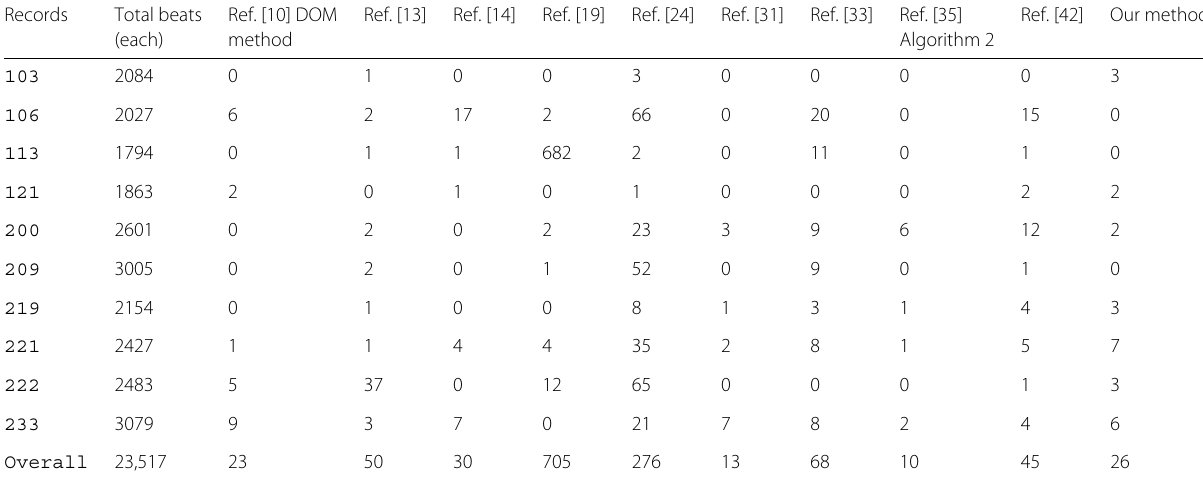
Table 4 Numbers of false-negatives (FNs) comparison for specific records